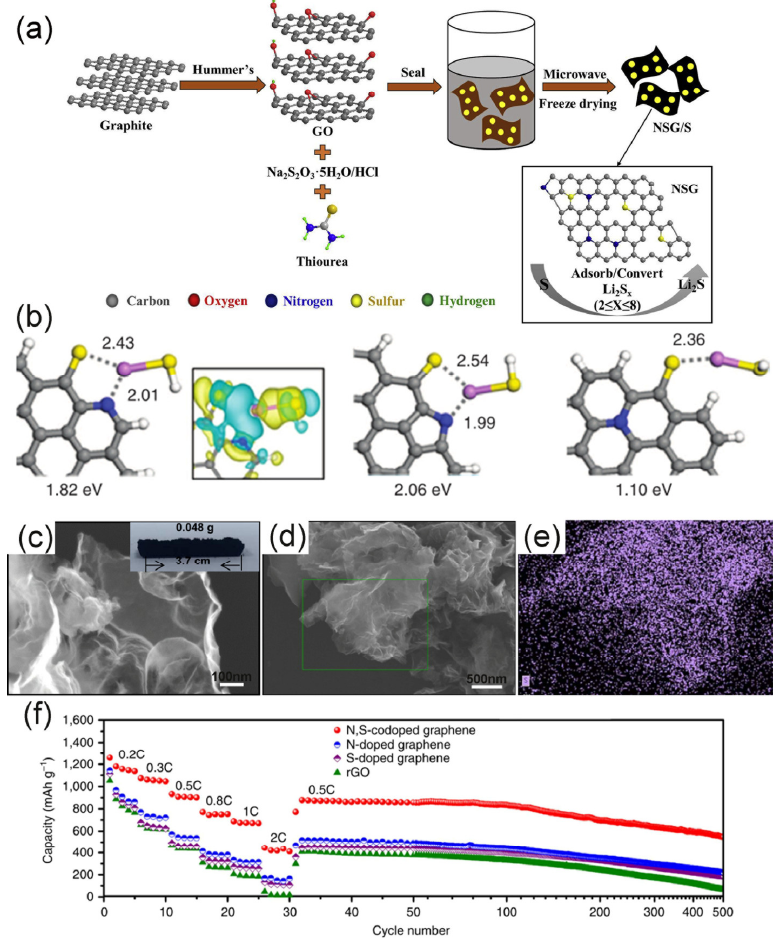
Figure 5. ( a ) Schematic diagram of one-pot synthesis of NSG/S [60]. Copyright 2018, Elsevier. ( b ) The binding energy of Li in LiPSs and N/S co-doped graphene between pyridine-N, pyrrole-N, and unbound N. Grey, white, blue, yellow, and purple balls represent C, H, N, S, and Li atoms, respectively [61]. Copyright 2015, Springer Nature. Morphology and microstructure of N, S-FLG900 ( c ) and N, S-FLG900/S ( d ) FESEM images and sulfur mapping ( e ) [86]. Copyright 2018, Royal Society of Chemistry. ( f ) Cycle performance test of various sulfur cathodes [61]. Copyright 2015, Springer